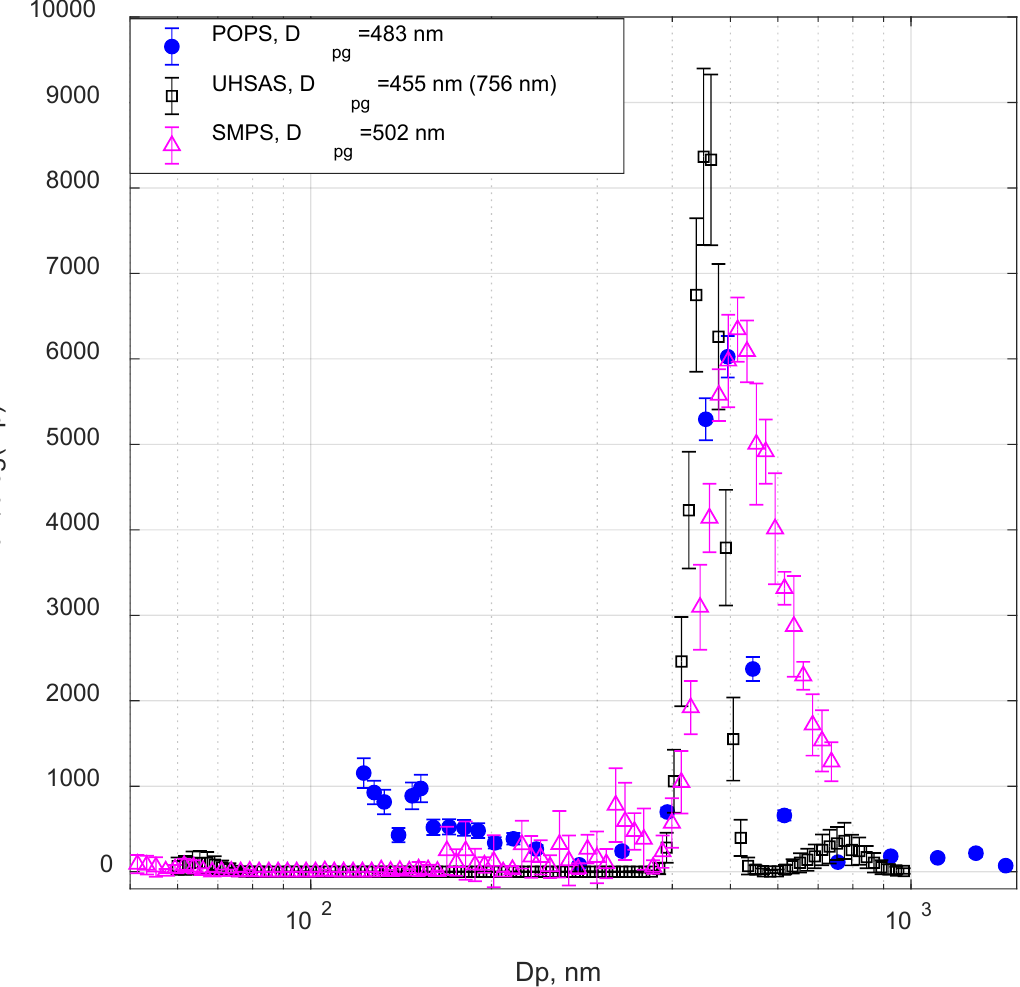
Figure 5. Size distribution comparison of 500 nm (electrical mobility size) ammonium sulfate particles.